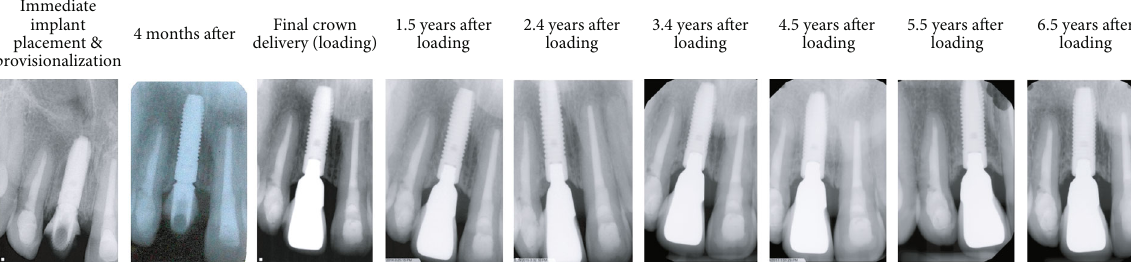
Figure 7: Periapical radiographs taken at immediate implant provisionalization and at various times during the 6.5-year recall